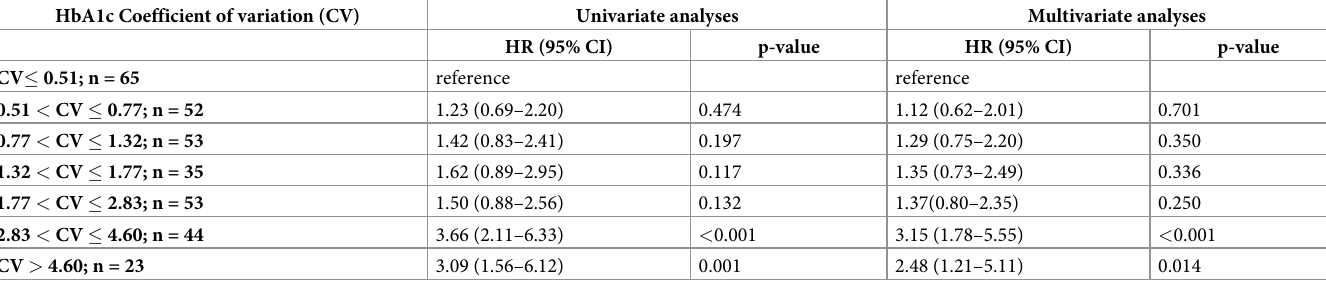
Hazard ratios (HR) with 95% confidence intervals (CI) were calculated using Cox regression analyses. In the multivariate analyses, adjustments were made for the all variables that turned out as statistically significant in Table 1.